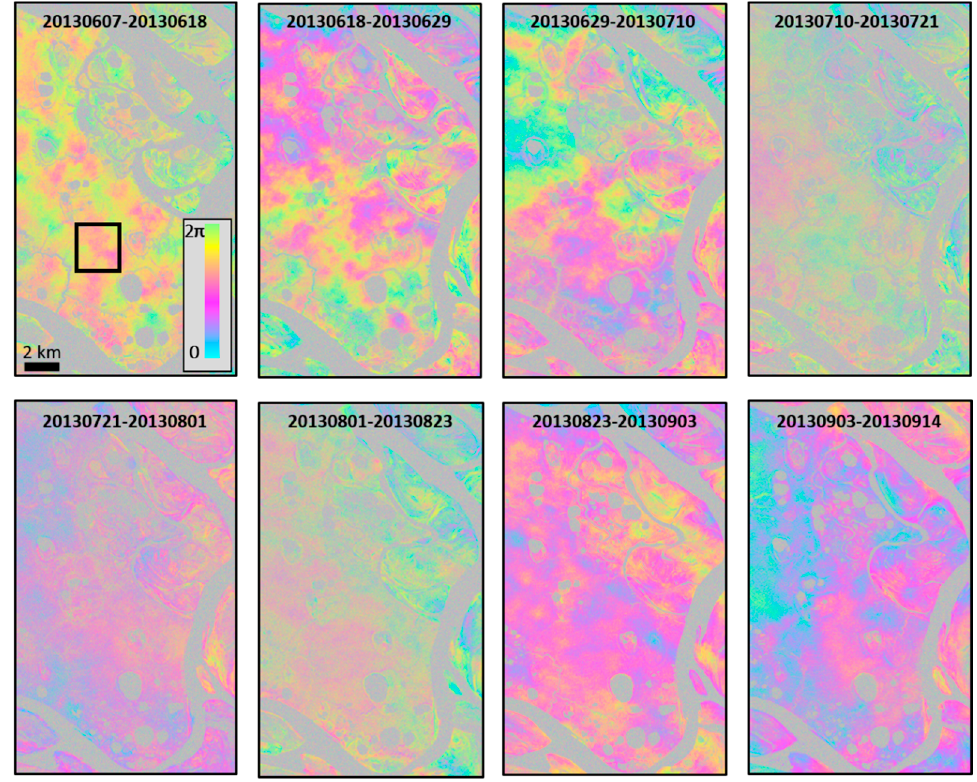
Figure A3. Subsets of differential interferograms in radar coordinates showing the studied island. Three interferograms in the middle of the season (20130710–20130721, 20130721–20130801, and 20130801–20130823) show a noisy phase pattern which corresponds to low coherence. The black box shows the sampling area for coherence histograms in Figure A2.